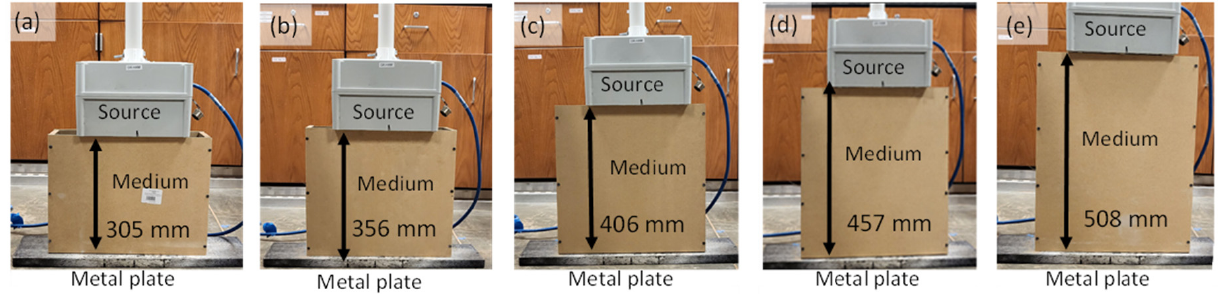
Figure 1. Experimental setup for scanning antenna at multiple depths: ( a ) 305 mm (12 inches), ( b ) 356 mm (14 inches), ( c ) 406 mm (16 inches), ( d ) 457 mm (18 inches), and ( e ) 508 mm (20 inches).